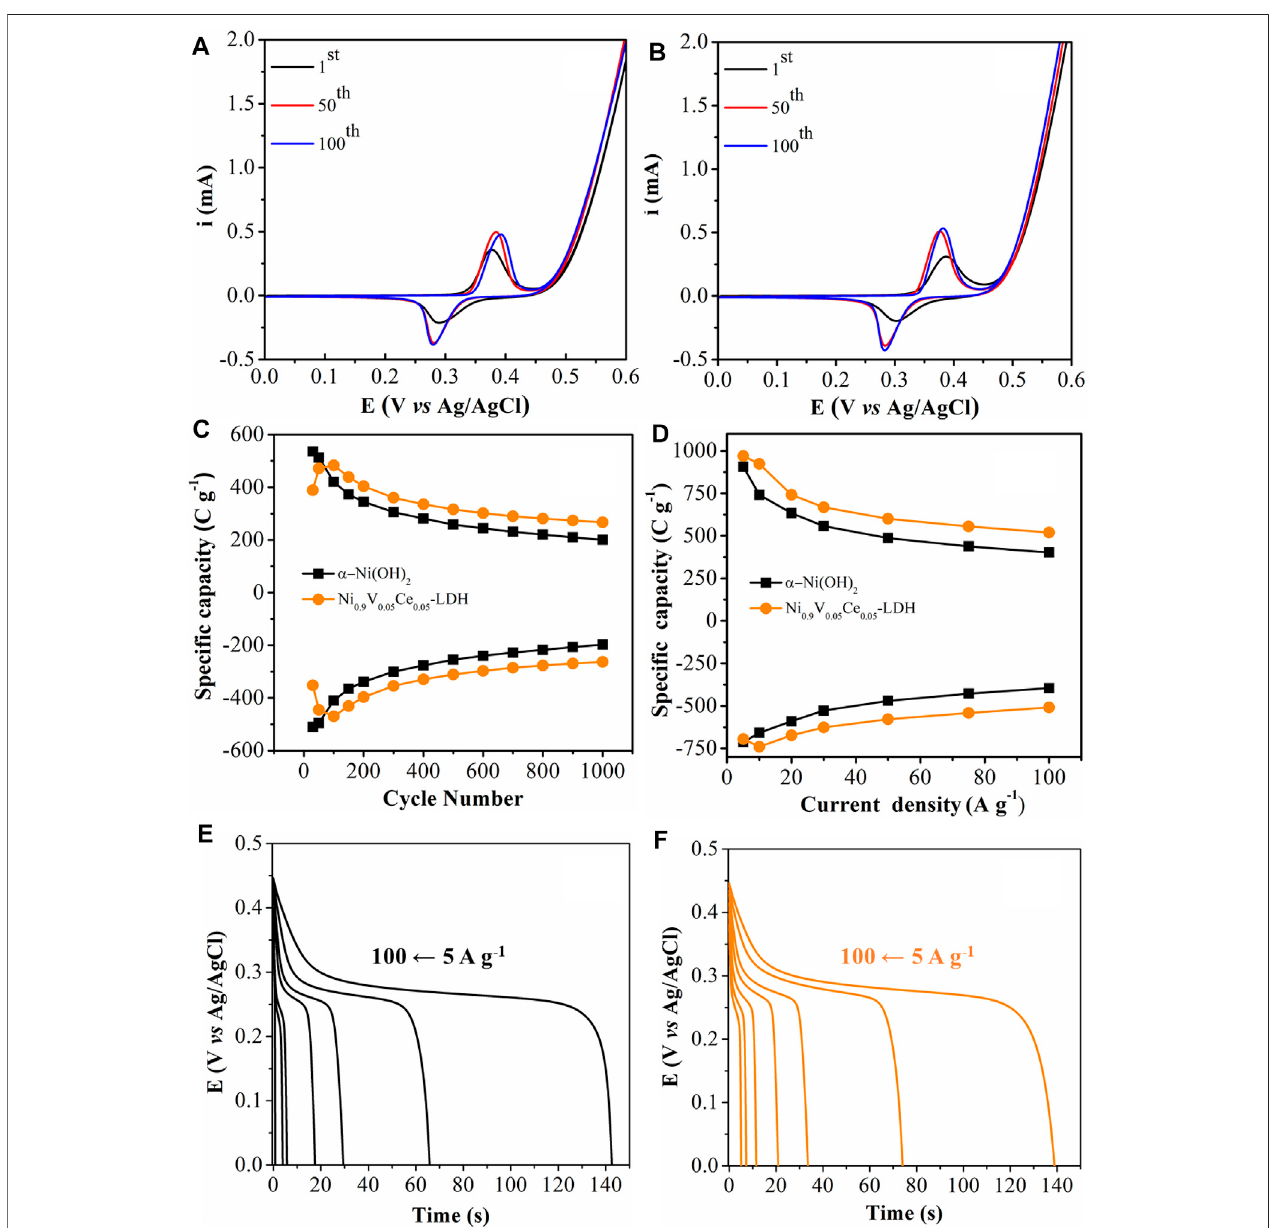
FIGURE4| SuccessiveCVsof (A) α -Ni(OH) 2 /FTOand (B) Ni 0.9 V 0.05 Ce 0.05 -LDH/FTOatv (cid:2) 50 mV s − 1 ,in1.0 mol L − 1 KOHsolution. (C) Cyclicstability. (D) Plotsof speci fi c capacity at different current densities (from 5 to 100 A g − 1 ). GCD curves at different current densities (from 5 to 100 A g − 1 ) for (E) α -Ni(OH) 2 /FTO and (F) Ni 0.9 V 0.05 Ce 0.05